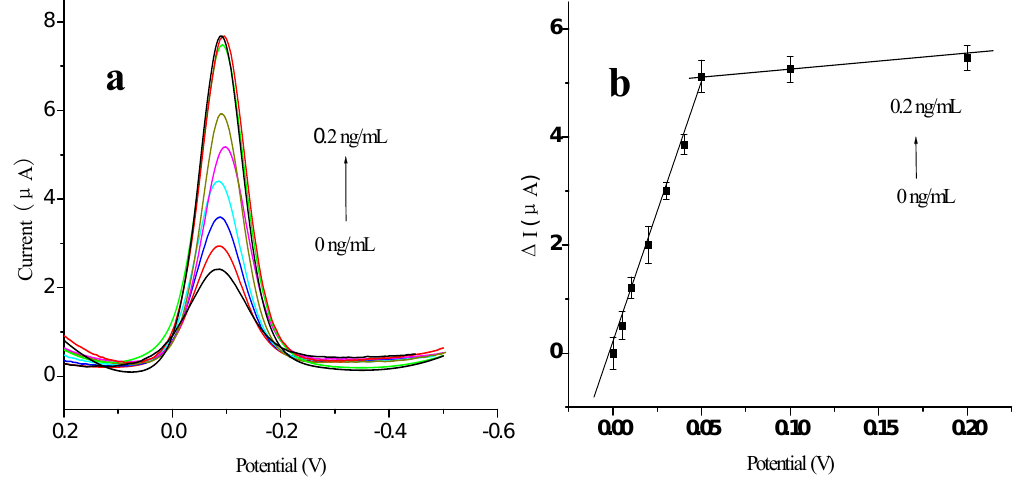
Figure 8. Voltammogram of modified electrode using different concentrations of antigen (0 ng/mL, 0.005 ng/mL, 0.01 ng/mL, 0.02 ng/mL, 0.03 ng/mL, 0.04 ng/mL 0.05 ng/mL, 0.1 ng/mL and 0.2 ng/mL, respectively): ( a ) DPV curves; ( b ) plot of Δ I vs. the concentrations of AFP. All experiments were carried out in 0.01 mol/L PBS/0.1 mol/L KCl (pH 7.4) and added 5 mmol/L HQ, at a potential range of 0.2 V to − 0.5 V, vs. SCE. Scan rate: 50 mV/s.